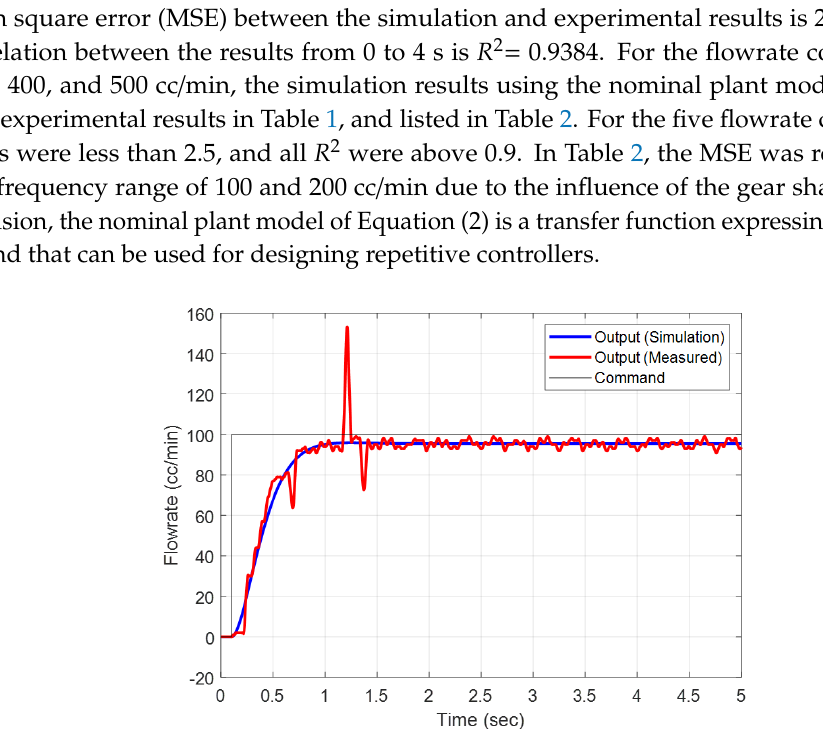
Figure 7. The measured flowrate output of the actual plant model, and the simulated flowrate output of the nominal plant model for the flowrate command of 100 cc/min. Table 2. Comparison of the measured flowrate output and simulation result using the nominal plant model.